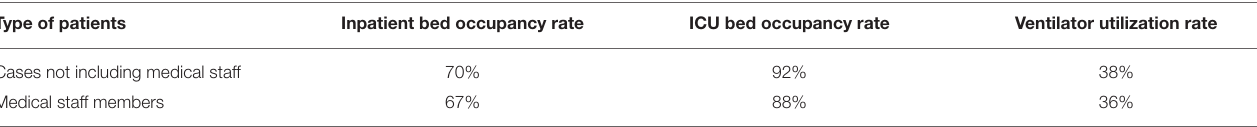
TABLE 2 | Inpatient bed occupancy and ICU bed occupancy and ventilator utilization rates for COVID-19 confirmed cases admitted to teaching hospitals (June 1 to July 15, 2020). Type of patients